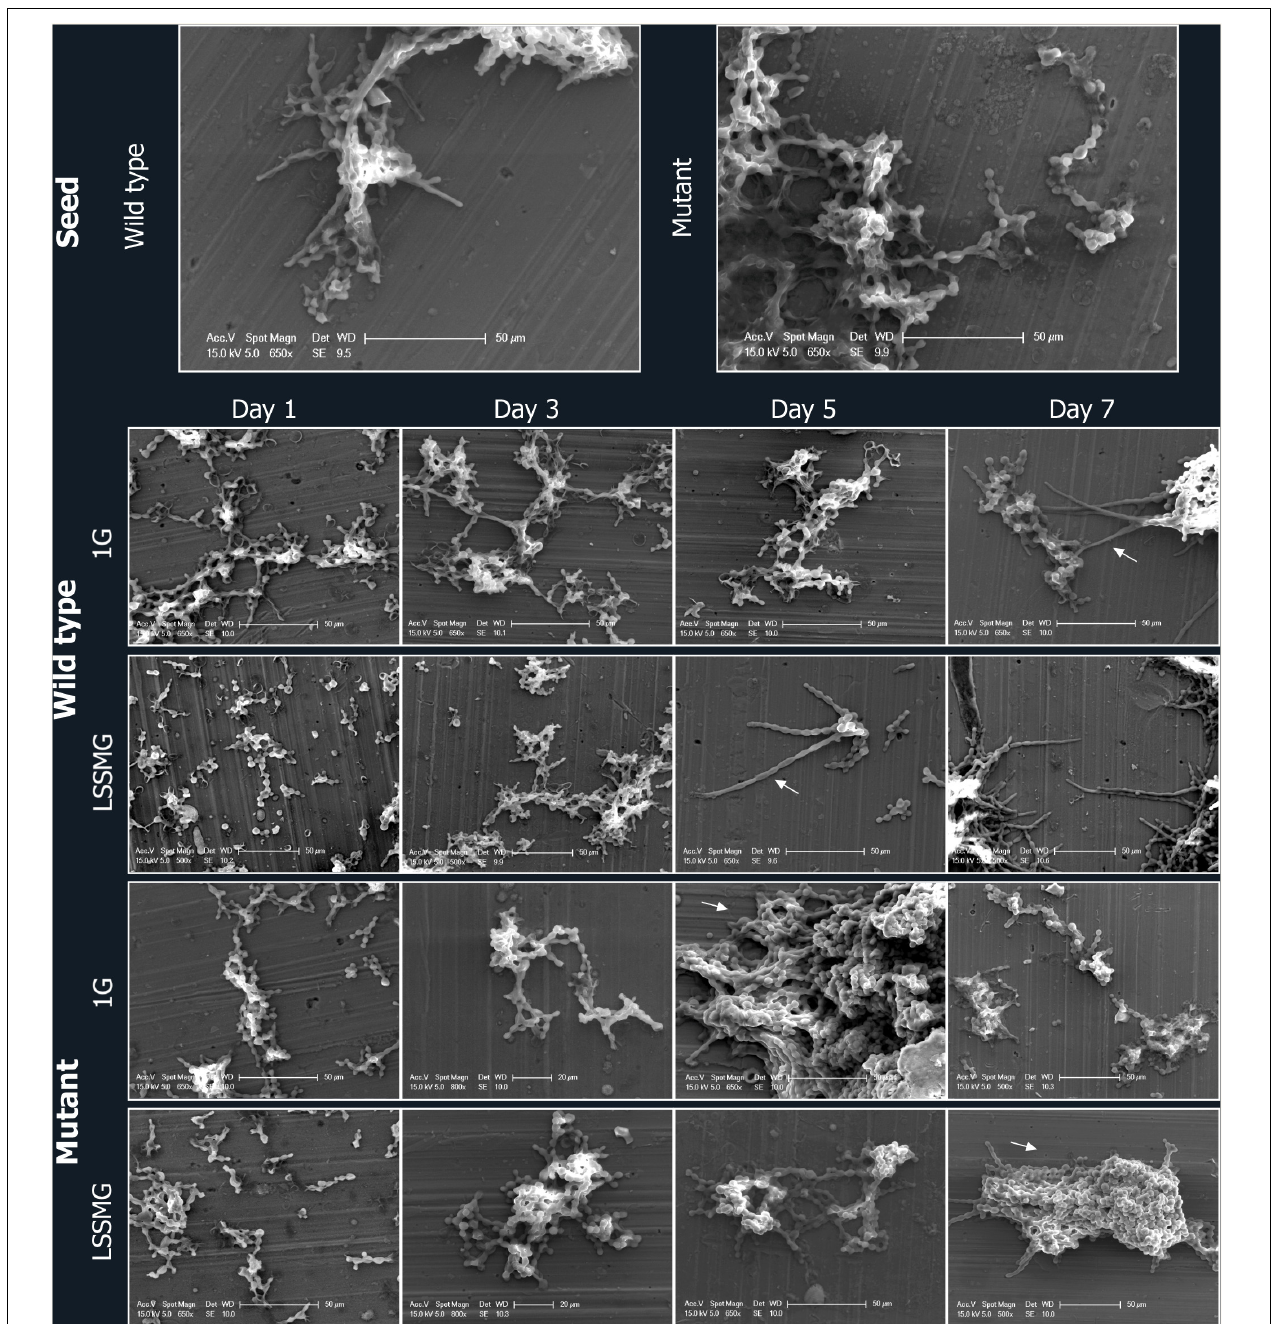
FIGURE 2 | Field emission scanning electron microscopy (FE-SEM) micrographs of Knufia chersonesos Wt and Mut on aluminum coupons during a 7-days exposure to LSSMG or 1G (control). Arrows indicate hyphal growth in the wild type and dense cell aggregation in the mutant strain.